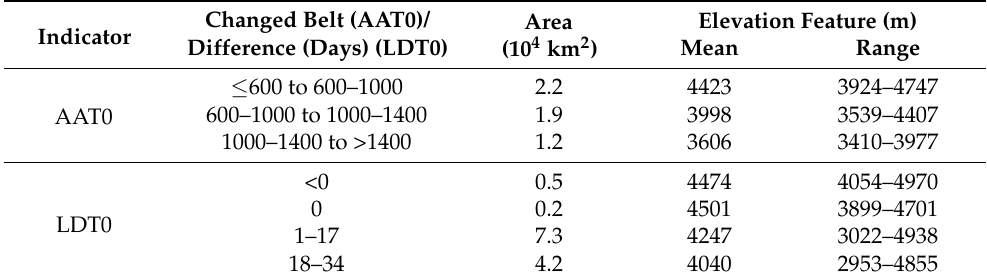
Figure 8. The distribution of averaged ≥ 0 ◦ C annual accumulated temperature before ( a ) and after ( b ) the abrupt year 1997 and the variation between the two stages ( c ) in the source region of the Yellow River. Table 10. The area and elevation features of the changed belt of the AAT0 and the difference of LDT0 between the stages before and after 1997.